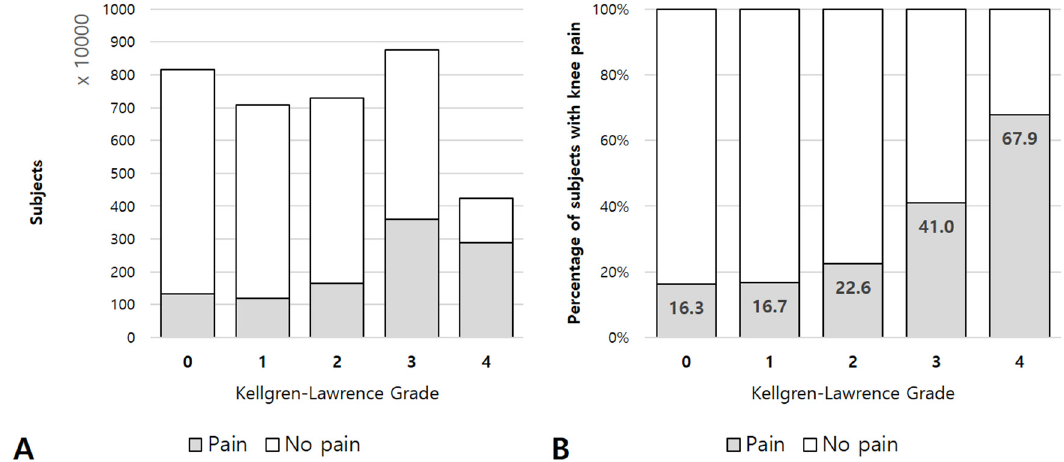
Figure 2. ( A ) Number of subjects according to Kellgren–Lawrence (KL) grades. ( B ) Percentage of subjects with knee pain for each KL grade. The proportion increased as KL grade increased ( p -value for trend <0.001).